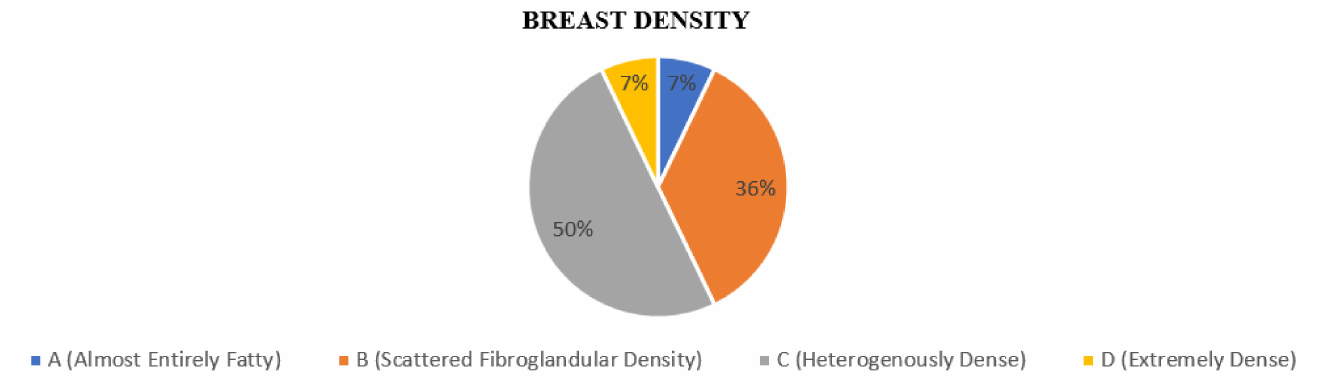
Figure 2. Proportion according to breast density on